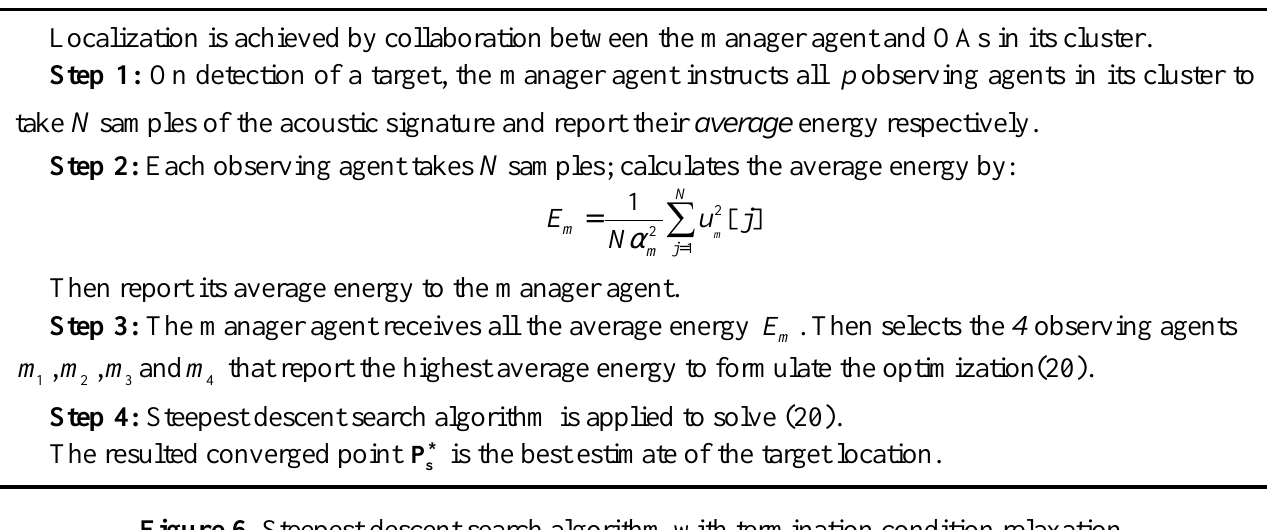
Figure 5. Agent collaborative localization algorithm.